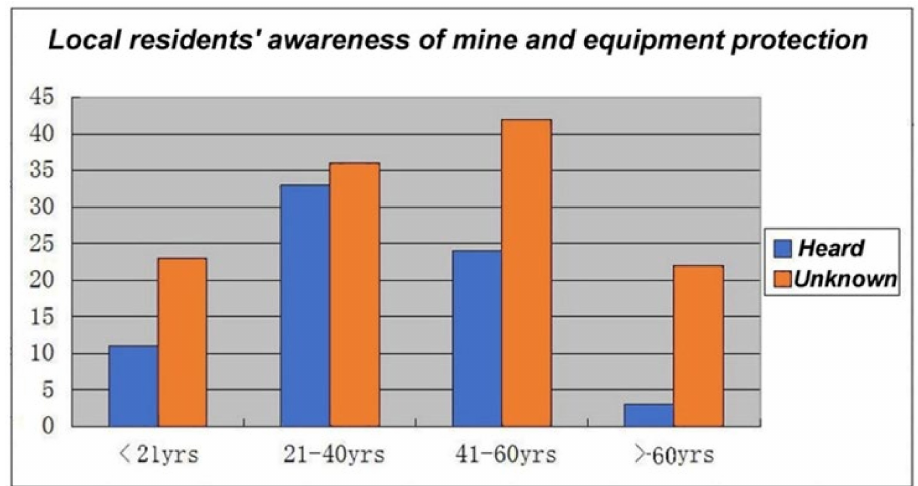
Figure 12. Does the resident have knowledge of the concept of protection of industrial heritage?